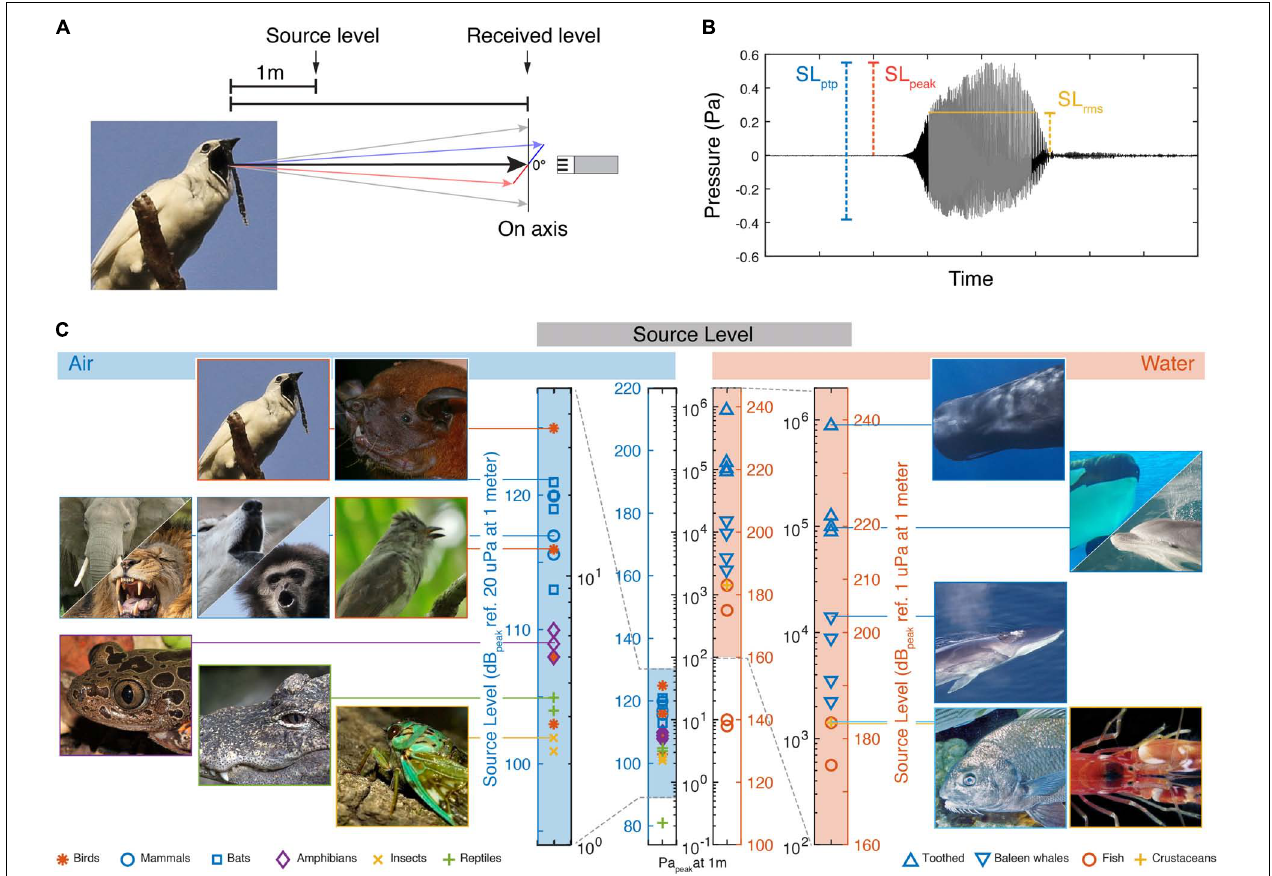
FIGURE 1 | Source levels of the loudest animals in air and water. (A) Source level is defined as the on-axis radiated sound pressure at 1 m distance from the source. (B) Three commonly used measures of pressure amplitude; SL peak is the highest absolute magnitude of the signal. SL ptp is the difference between highest and lowest amplitude. SL rms is here shown as the rms amplitude over the duration set by using a 95% energy threshold criterion [see Madsen and Wahlberg (2007) for detail]. (C) SLs of the loudest reported animals in air and water (For data points and references see Table 1 ). The two vertical bars of pressure in the middle are on the same absolute pressure scale to allow direct comparison of the different dB scales in air and